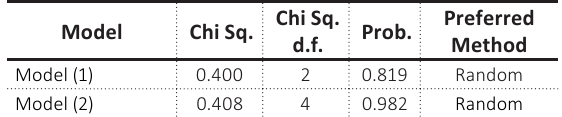
Table 10. Husman test